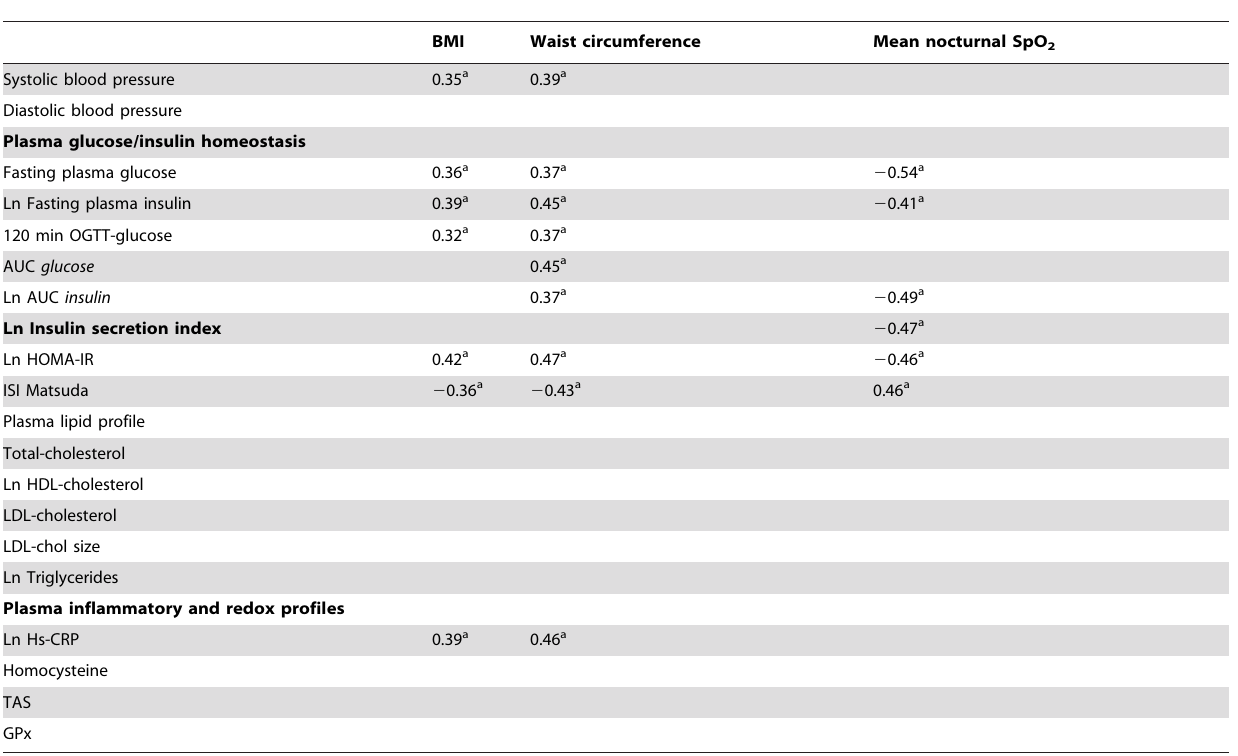
Table 2. Univariate Pearson